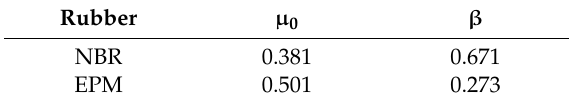
Table 2. Interaction coefficients between rubber network and toluene at 25 ◦ C.